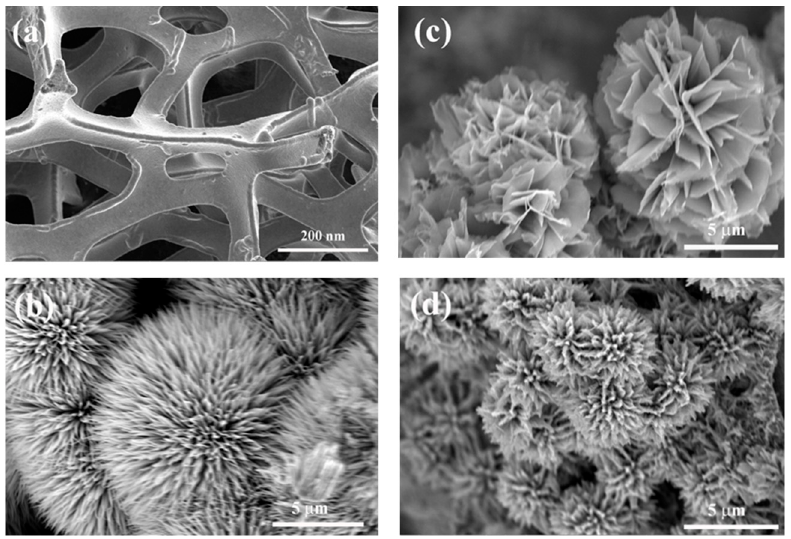
Figure 3. An SEM image of different samples ( a ). pure NF, ( b ). NiCo 2 O 4 nanocones on NF, ( c ). NiCo 2 O 4 nanosheets on NF, ( d ). core-shell NiCo 2 O 4 @NiCo 2 O 4 /NF composites).